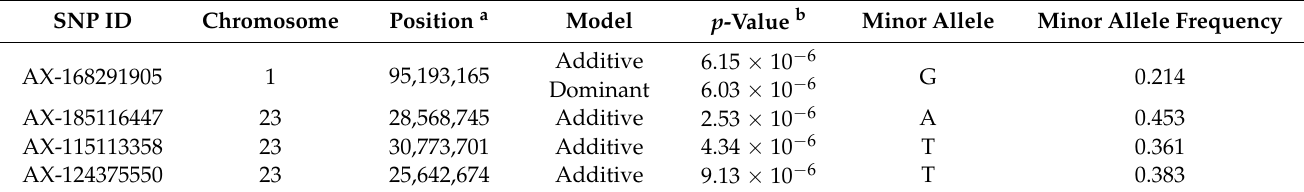
Figure 1. Quantile–quantile (QQ) plots before and after the control of sample stratification. Early deviations of the p -values from expected p -values suggest population stratifications. The genomic inflation factors ( λ ) were 1.20, 1.16, and 1.31 in the Additive, Dominant, and Recessive models, respectively ( a ). QQ plots after the control of sample stratification by the genomic control method ( b ). Table 1. Single-nucleotide polymorphisms (SNPs) with significant difference as a result of genome- wide association